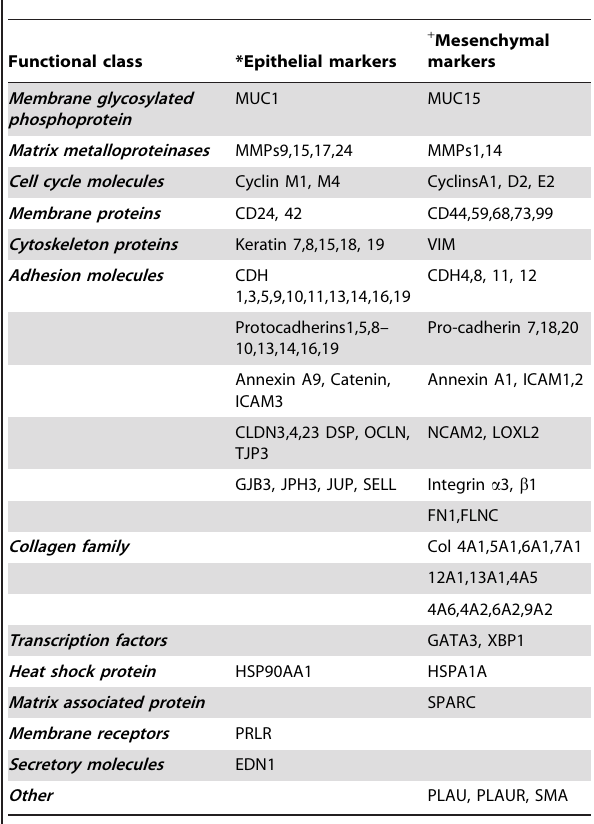
Table 4. Epithelial and mesenchymal